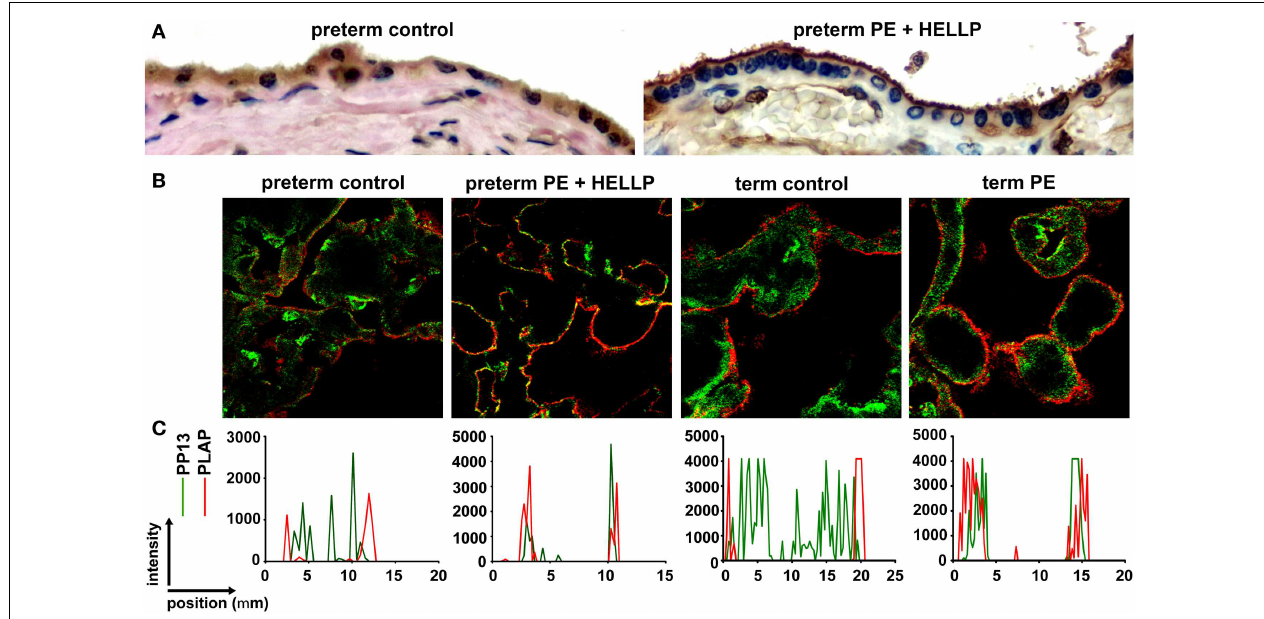
relocalization of PP13 (green) near to placental alkaline phosphatase (PLAP) immunopositive (red) lipid rafts in the juxtamembrane regions of the syncytiotrophoblast in term preeclampsia and preterm preeclampsia associated with HELLP syndrome compared to controls. (C) Line scan intensity distributions of PP13 and PLAP in representative confocal images shown in subfigure (B) . Figure (A) was published in Ref. (36). Figures (B,C) were published in Ref. (73). Kind permission for the reuse of the figures was obtained from Springer Science + Business Media (A) and Elsevier (B,C)